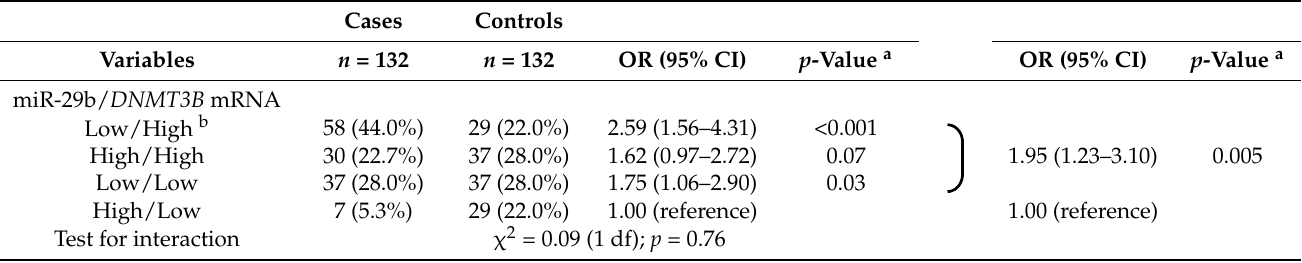
Table 3. Joint effects of miR-29b and DNMT3B mRNA in lung cancer development.